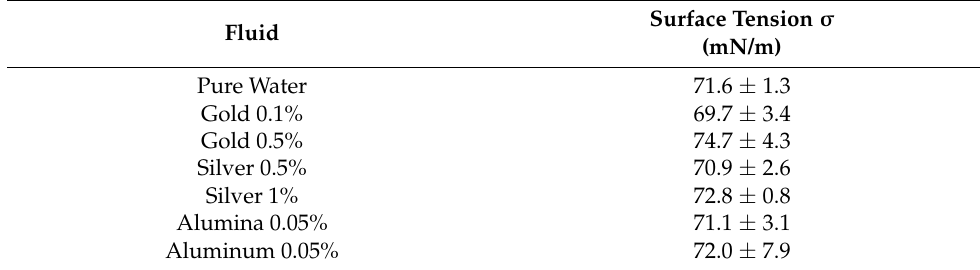
Table 3. Mean surface tension values for pure water and different nanofluids, at a temperature of 20 ◦ C.